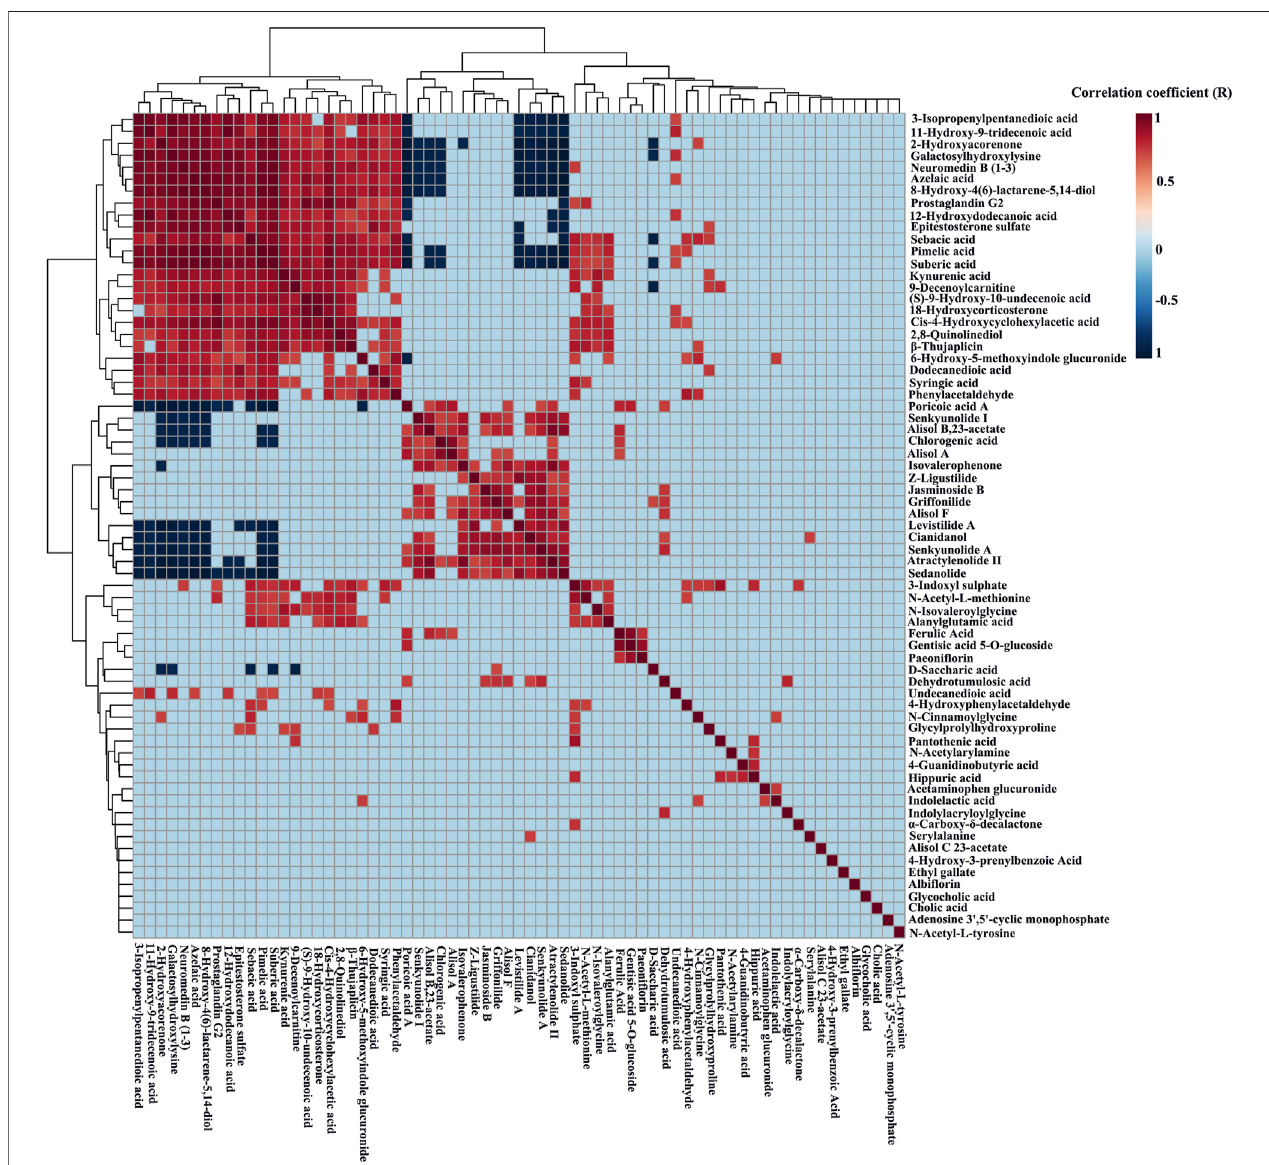
FIGURE5| Correlation heatmapbetweentheserumconstituentsofDSSand thepotentialbiomarkersofPDbasedonthemetaboanalyst5.0platform.Heatmaps were drawn based on the relative level of the serum components and potential biomarkers.